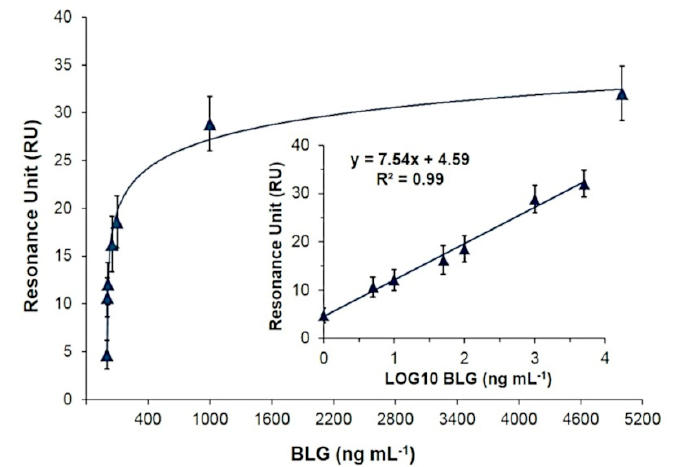
Figure 5. The non-linear and linear calibration plots (inset plot) for the BLG cumulative assay. Relative responses were normalised by subtracting the control response. The error bars refer to the SD (±) of three replicates. The achieved LOD was as low as 3.10 ng mL − 1 .